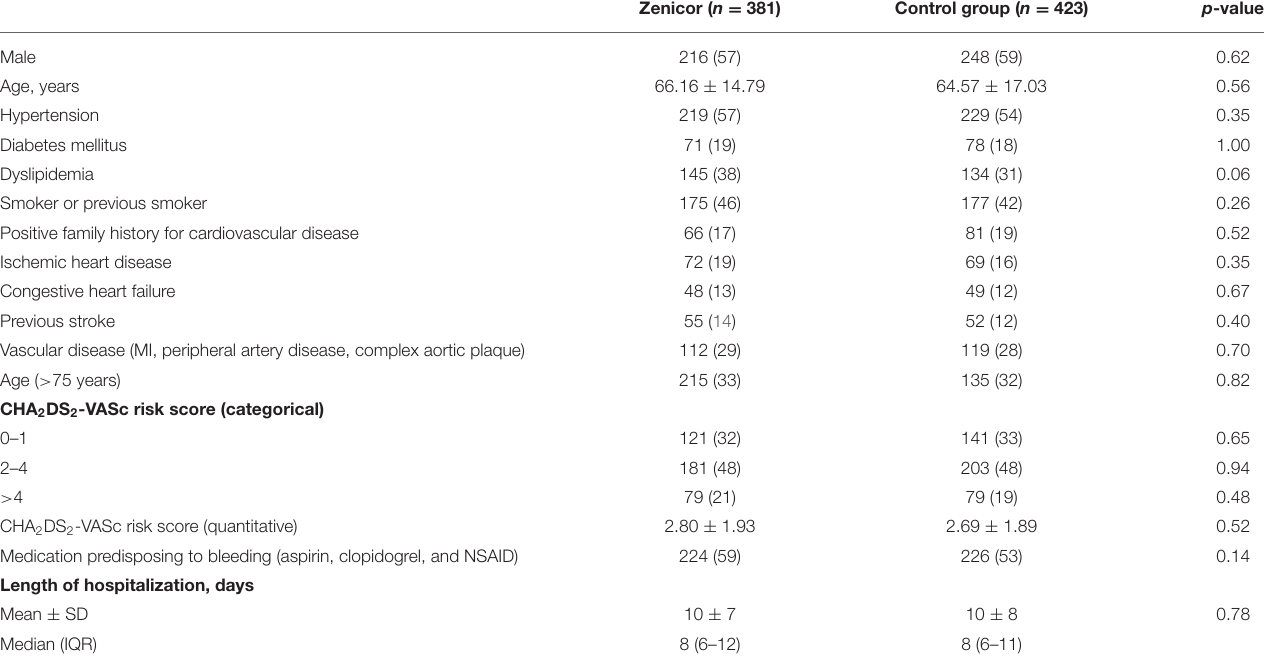
TABLE 1 | Baseline patient characteristics.